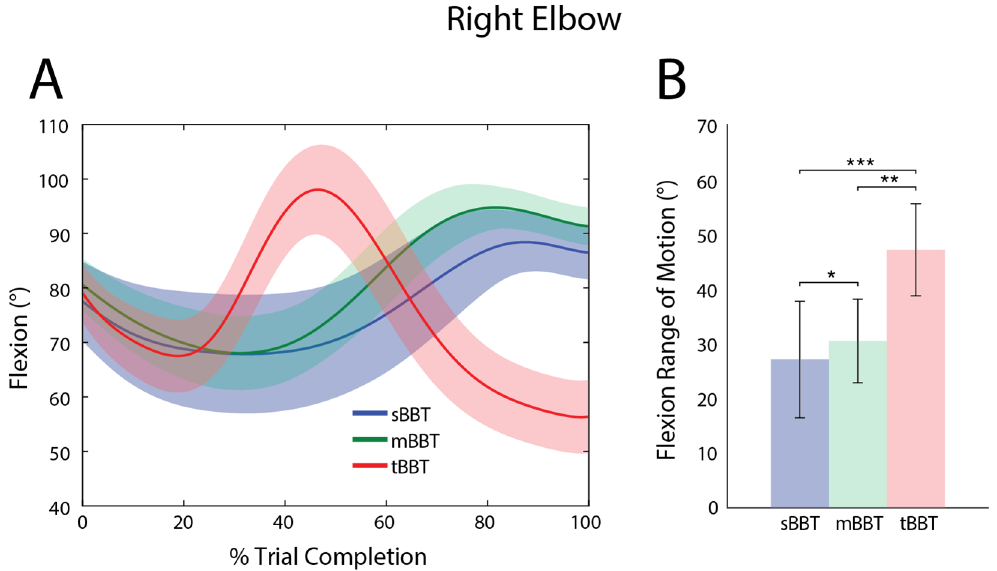
Fig 4. Kinematic trajectoriesand RoM of the right elbow. Kinematic trajectories and RoM of the right elbow for the sBBT (blue), mBBT (green), and tBBT (red). (A) Right elbow flexionas a function of percent trial completion, averagedover all subjects for each BBT. (B) Right Elbow